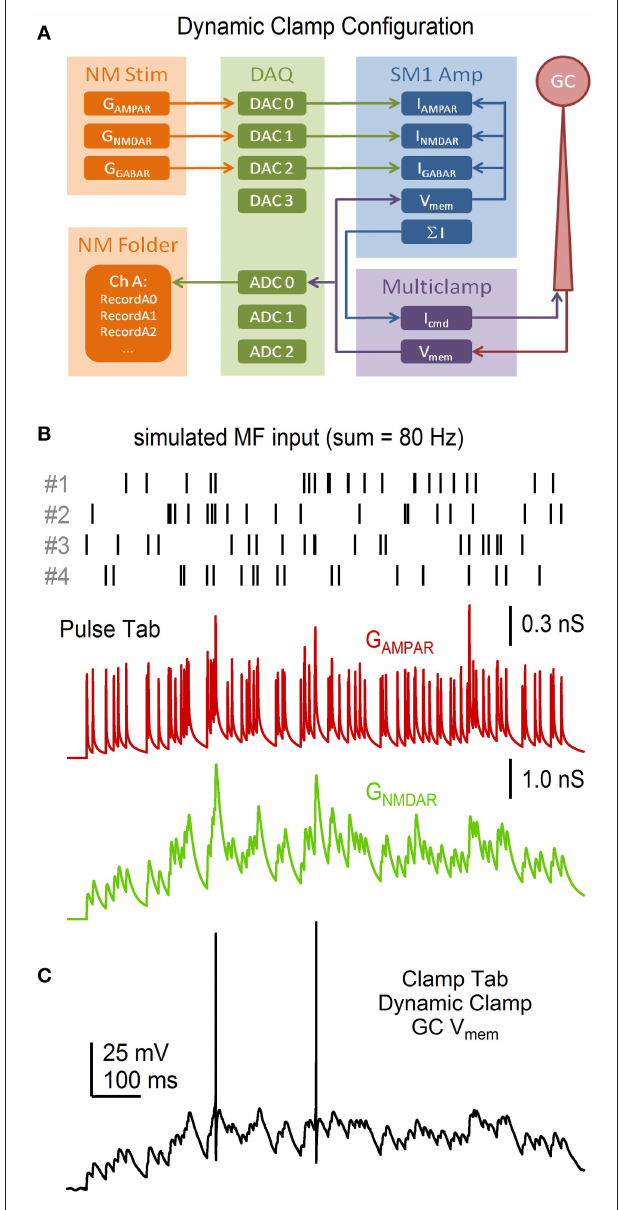
FIGURE 14 | Dynamic-clamp acquisition using simulated synaptic conductance trains. NeuroMatic Pulse tab R · P plasticity models were used to simulate 4 statistically different MF inputs with mean spike rate f . The 4 MF inputs were summed together and injected into a real GC via dynamic clamp. (A) Flowchart of the dynamic-clamp experiment. NeuroMatic sent precomputed G AMPAR , G NMDAR and G GABAR waves to 3 DAC channels of a DAQ device, which were connected to the appropriate input channels of a dynamic-clamp SM1 amplifier. In real time, the SM1 amplifier converted the conductances to currents using V mem of the GC, via the Multiclamp amplifier, and preset reversal potentials, i.e., I = G · (V mem – V rev ). The sum of the 3 currents was sent to the command input of the Multiclamp amplifier (I cmd ). The Multiclamp amplifier recorded the GC V mem response to I cmd and sent V mem to an ADC channel of the DAQ device, which was read by NeuroMatic. (B) Synaptic event times for 4 simulated MF inputs (top) computed by the Pulse tab. Event times had random Poisson intervals > 1ms with f = 20Hz.